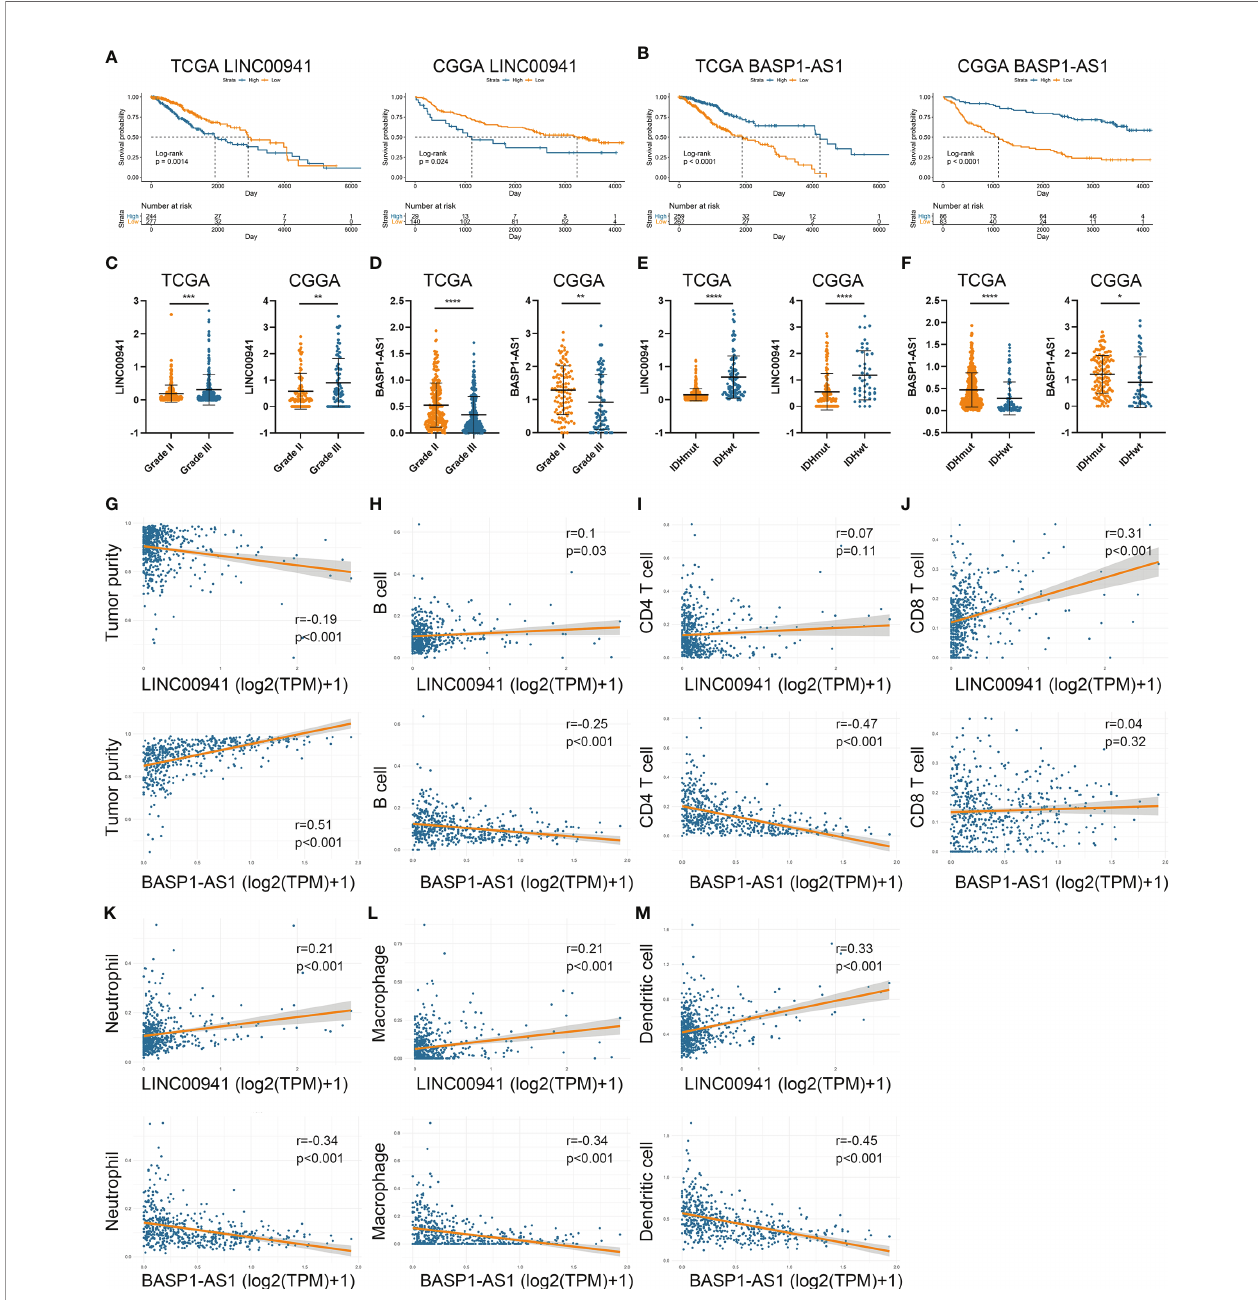
FIGURE 7 | LINC00941 and BASP1-AS1 were associated with the prognosis and immune in fi ltration in LGG. (A, B) Kaplan-Meier analysis of LINC00941 and BASP1-AS1 in LGG patients of TCGA (A) and CGGA (B) datasets. (C, D) The expression of LINC00941 (C) and BASP1-AS1 (D) in grade II and III gliomas. (E, F) The expression of LINC00941 (E) and BASP1-AS1 (F) in IDH wildtype and IDH mutant gliomas. (G) The correlation between LINC00941 and BASP1-AS1 with tumor purity. (H – M) The correlation between LINC00941 and BASP1-AS1 with the abundance of B cell (H) , CD4+ T cell (I) , CD8+ T cell (J) , neutrophil (K) , macrophage (L) , and dendritic cell (M) . *p < 0.05, **p < 0.01, ***p < 0.001, ****p <